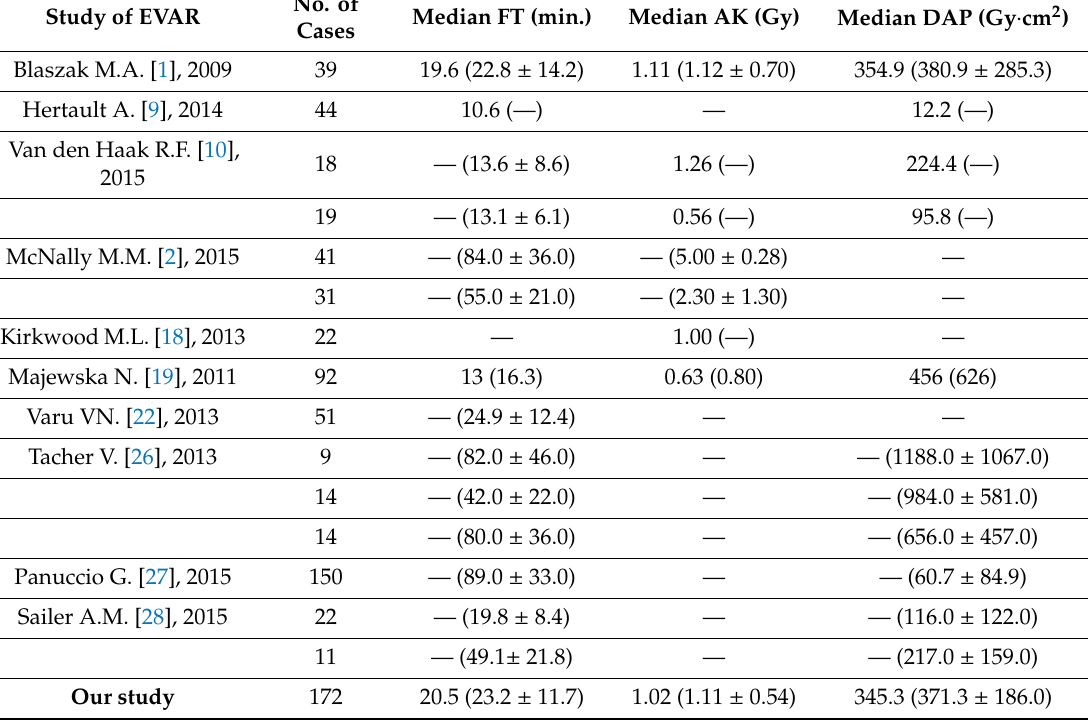
Table 5. Overview of reports describing the endovascular treatment of abdominal aortic aneurysms (EVAR) in